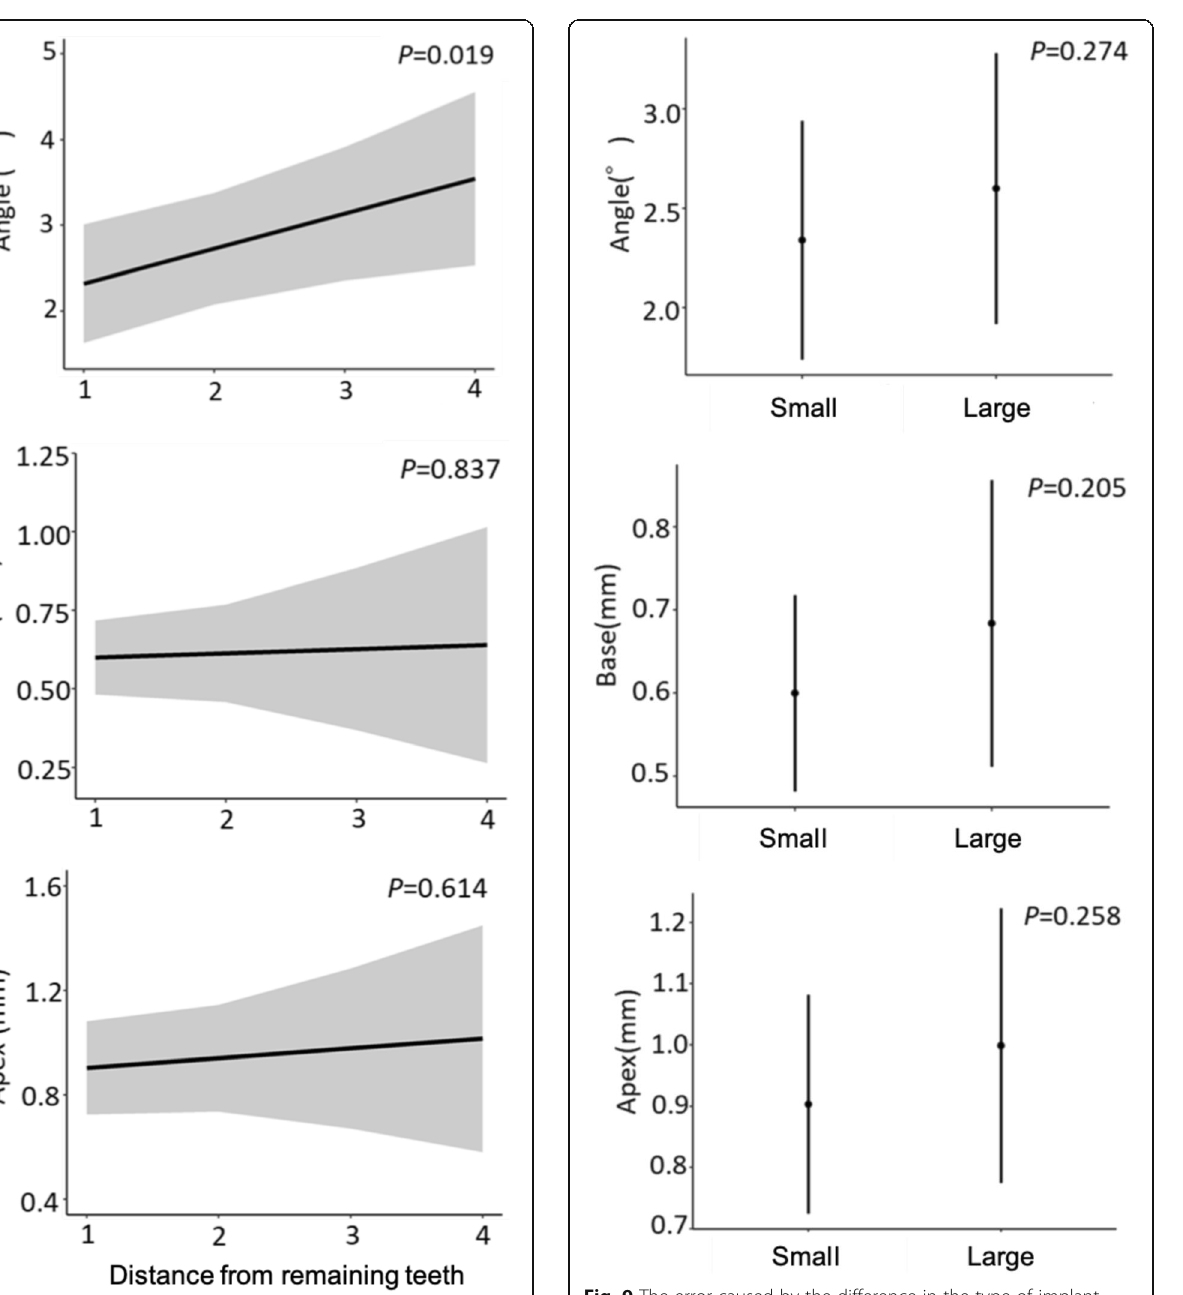
Fig. 9 The error caused by the difference in the type of implant with large and small diameter differences between the implant mount and the metal sleeve. Error bars indicate 95% confidence